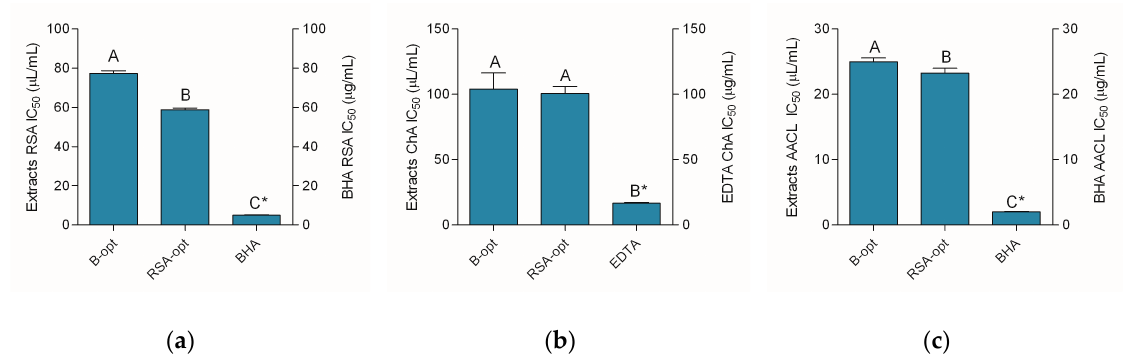
Figure 2. Antioxidant activity of the extracts and positive controls—BHA (butylated hydroxyanisole) and EDTA (ethylenediaminetetraacetic acid): ( a ) antiradical activity, ( b ) chelating activity, and ( c ) the activity in β -carotene-linoleic acid assay. Di ff erent uppercase letters indicate statistical significance ( p < 0.05). Asterisks (*) indicate that the IC 50 unit is placed on the right y